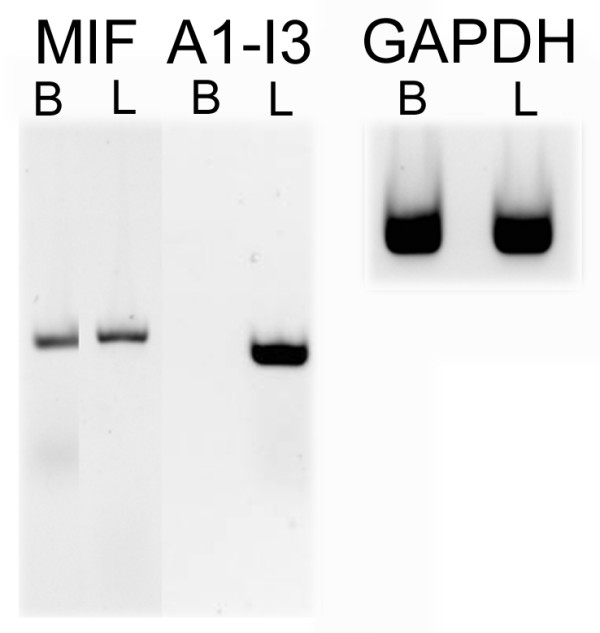
MIF and A1-I3 expression in the bladder and the liver. MIF and A1-I3 mRNA were amplified by RT-PCR. Resulting PCR products were resolved on 2% agarose gels. A single MIF band was detected in both the bladder (B) and liver (L). A1-I3 message was detected only in the liver (L), but not in the bladder (B). GAPDH RT-PCR documented similar amounts of total RNA were extracted and amplified in both bladder (B) and liver (L).